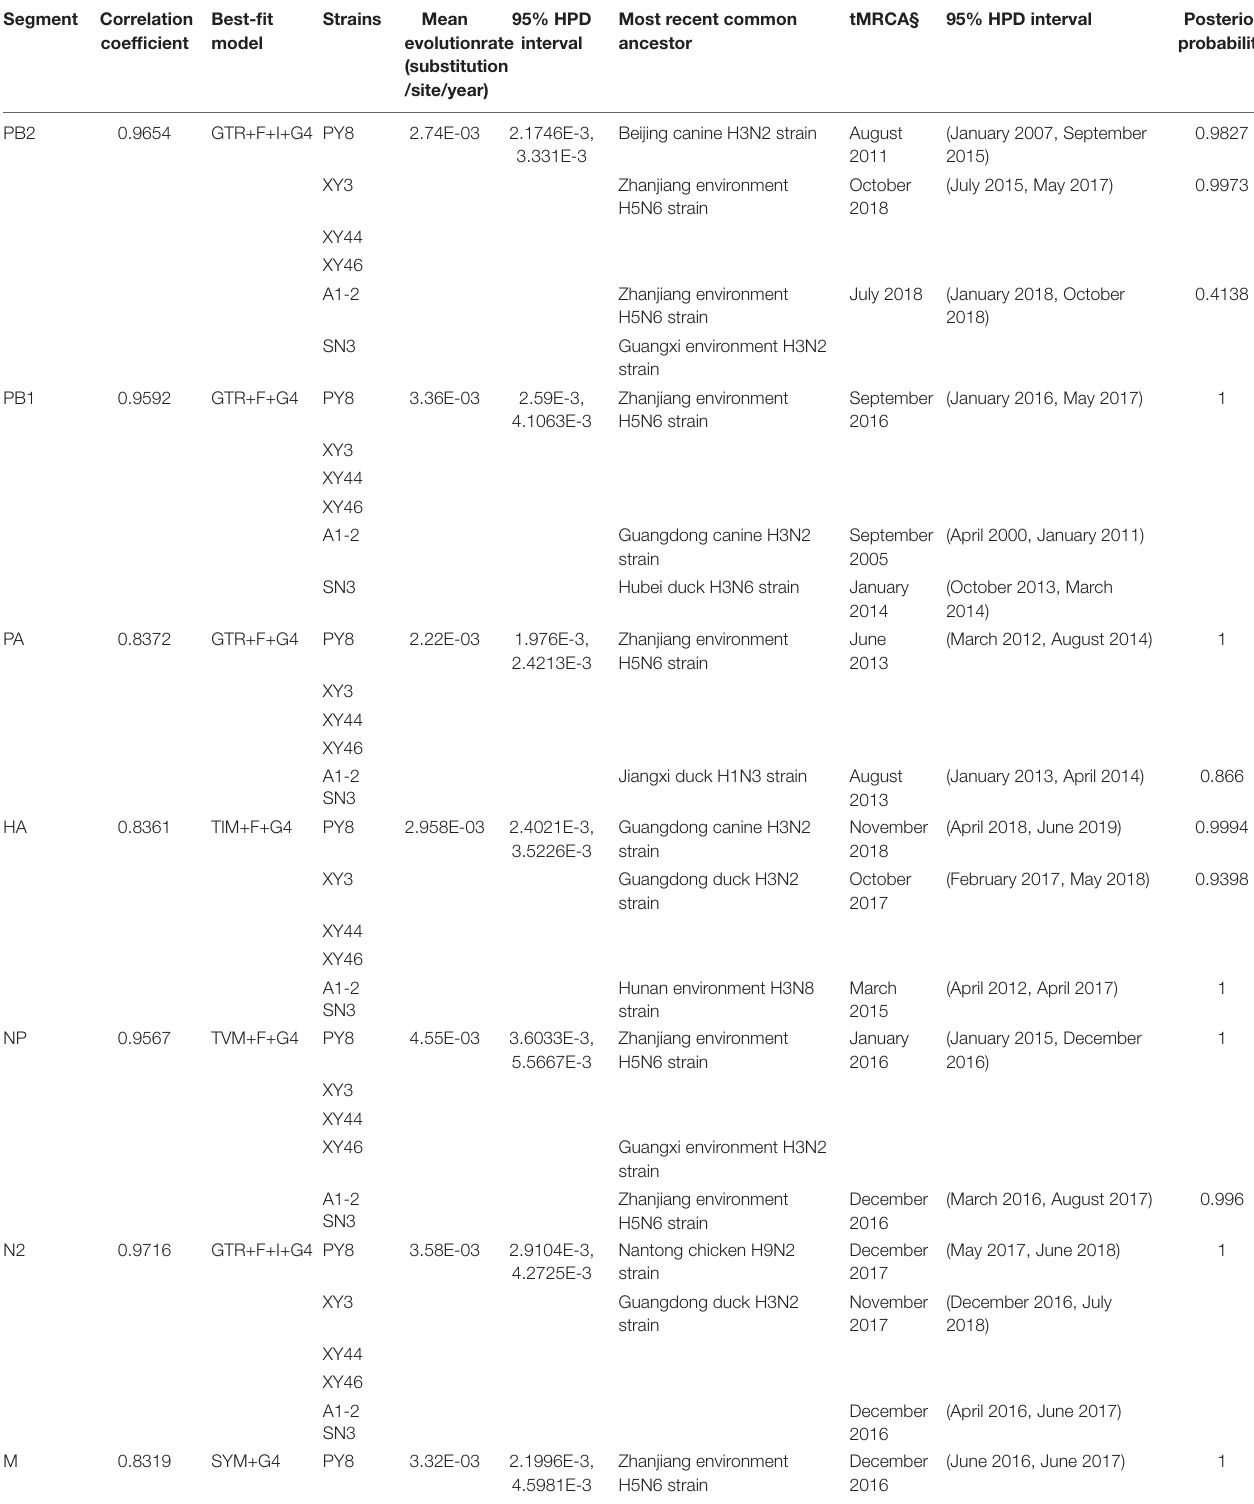
TABLE 2 | Evolution rate and time of most recent common ancestor for each of the eight segments. Segment Correlation Best-fit coefficient